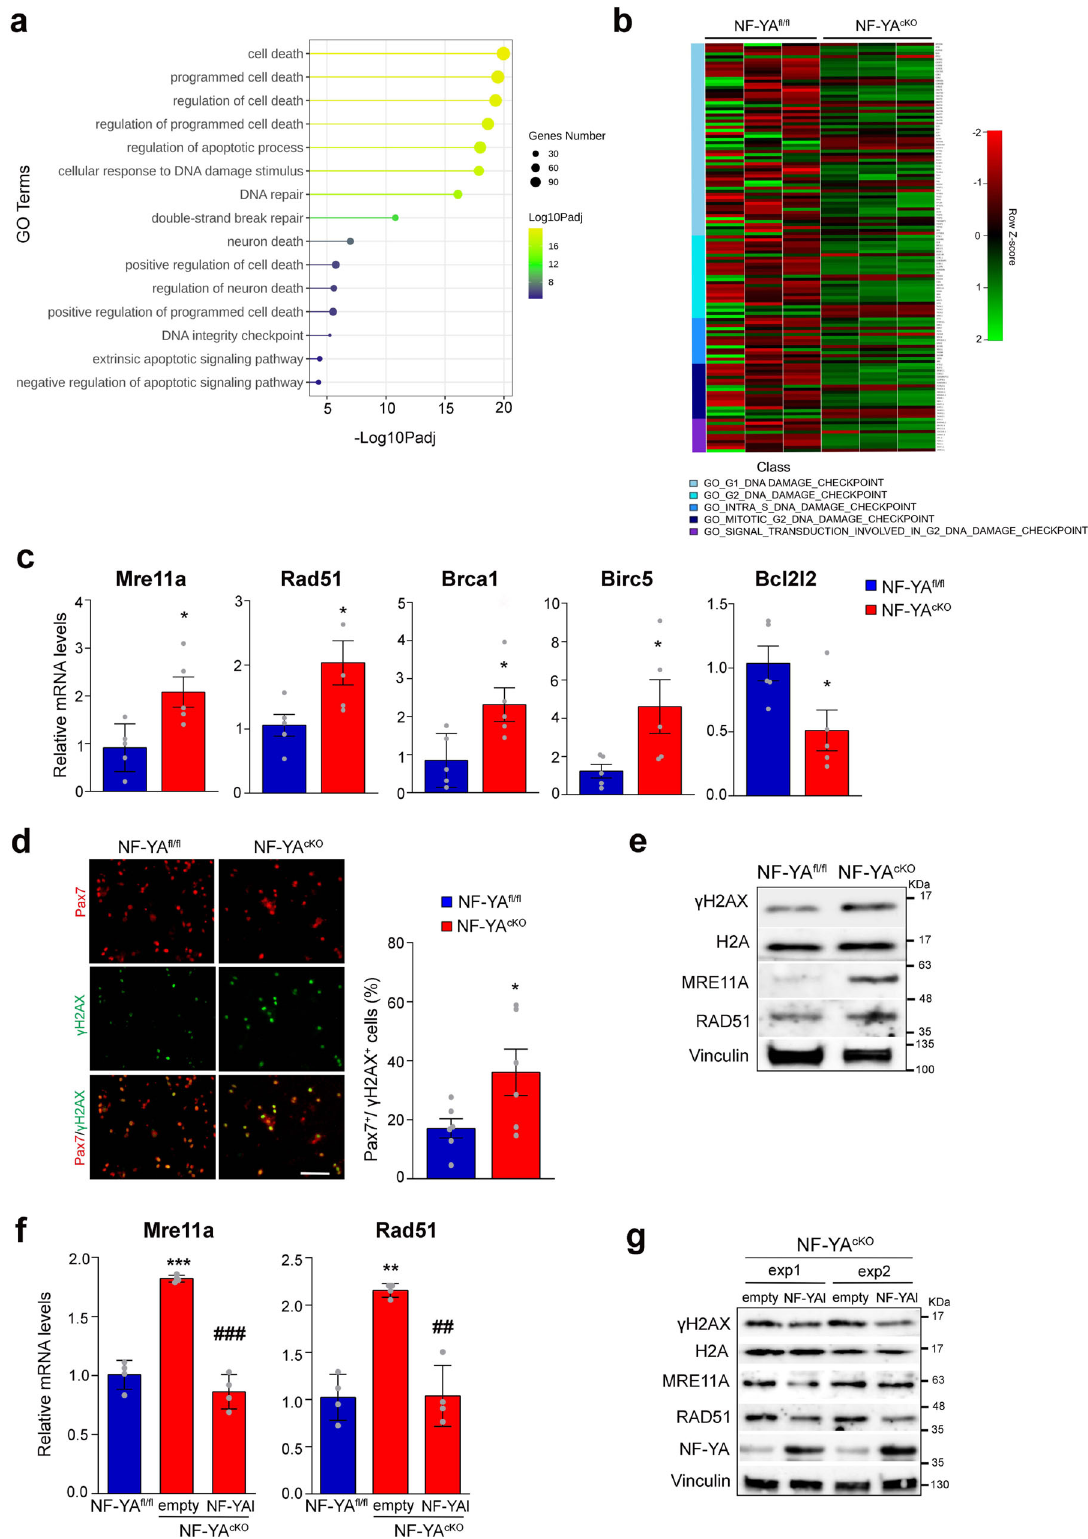
antibodies were incubated in blocking mix over-night at 4°C in a humid chamber. After three washes with PBS, the cells were incubated for 1h with secondary antibodies (1:500, AlexaFluor Thermo Fisher Scienti fi c) and DAPI, washed three times with PBS and mounted on slides with mowiol. The following primary antibodies and dilutions were used: rabbit anti-NF-YA (1:100, Thermo Fisher Scienti fi c), rabbit anti-NF-YA (H-209), (1:100, sc-10779 Santa Cruz Bio- technology), rabbit anti-laminin (1:500, ab11575 Abcam), mouse anti-Pax7